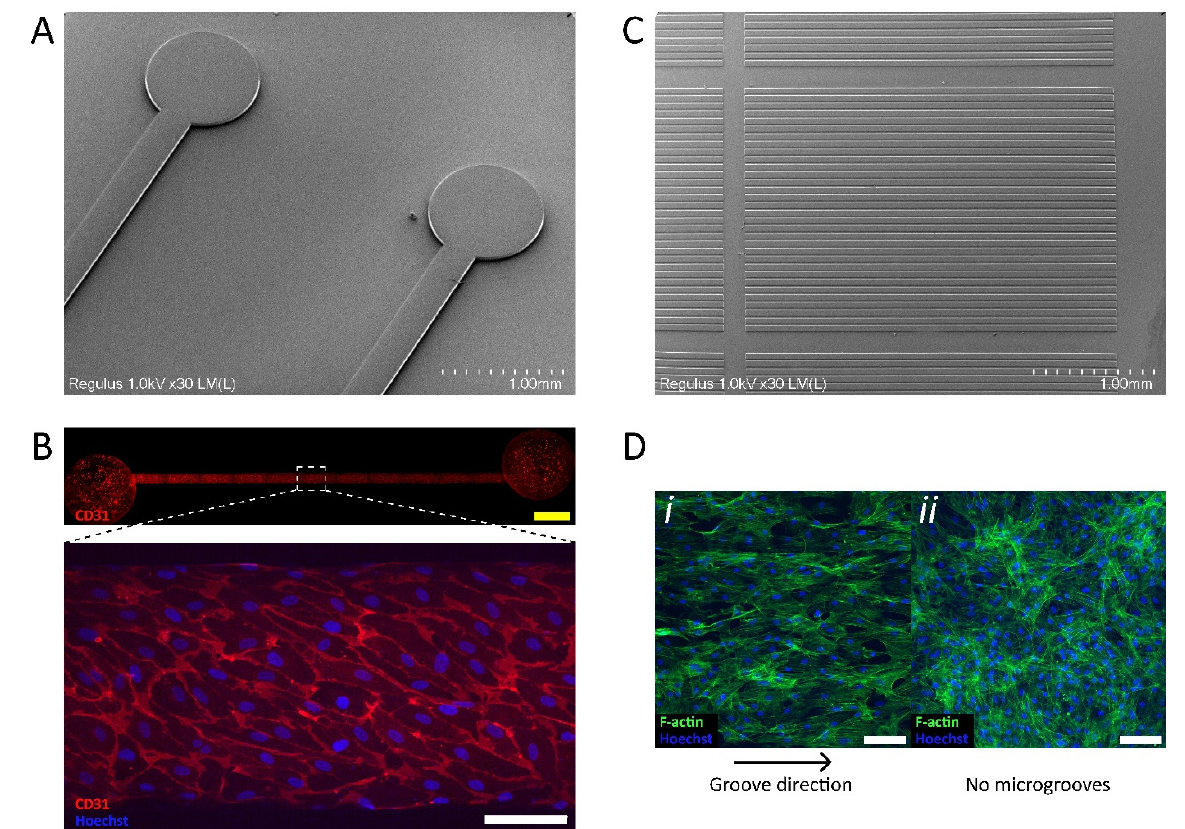
Figure 3. Fabrication of microchannels and microgrooves. ( A ) SEM image of 50 µm tall SU-8 structures to fabricate straight microfluidic channels 12 mm in length. ( B ) Representative immunofluorescence image of hiPSC-derived ECs upon 3 days of culture in microfluidic chip fabricated using SU-8 mold shown in A. ECs display typical morphology with an endothelial-specific CD31 marker located at the cell-cell junctions. ( C ) SEM image of 6 µm deep SU-8 microgrooves 5 mm in length (fabricated with a 20X objective). Grooves are 20 µm wide, while ridges are 50 µm wide. ( D ) Representative immunofluorescence image of hiPSC-derived vSMCs stained with phalloidin (F-actin) upon 5 days of culture on PDMS microgrooves fabricated using SU-8 mold shown in C (microgrooves are now inversed and are 50 µm wide, while ridges are 20 µm wide). (i) Aligned vSMCs cultured on microgrooves and (ii) non-aligned vSMCs cultured on flat PDMS that lacks microgrooves, as evident by F-actin staining. White scale bars: 100 µm. Yellow scale bar: 1000 µm.